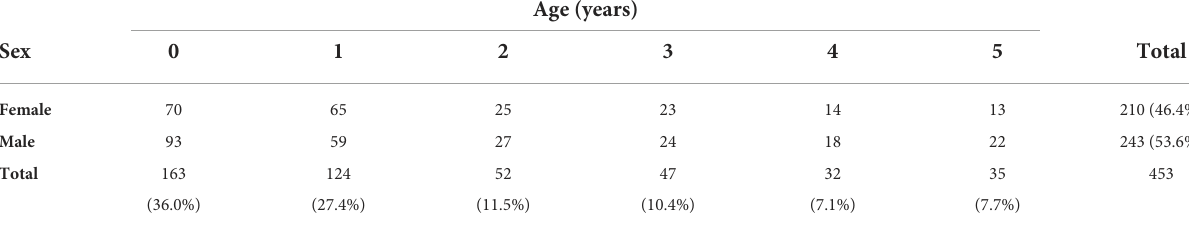
TABLE 2 Study population characteristics of respiratory panels performed: age and